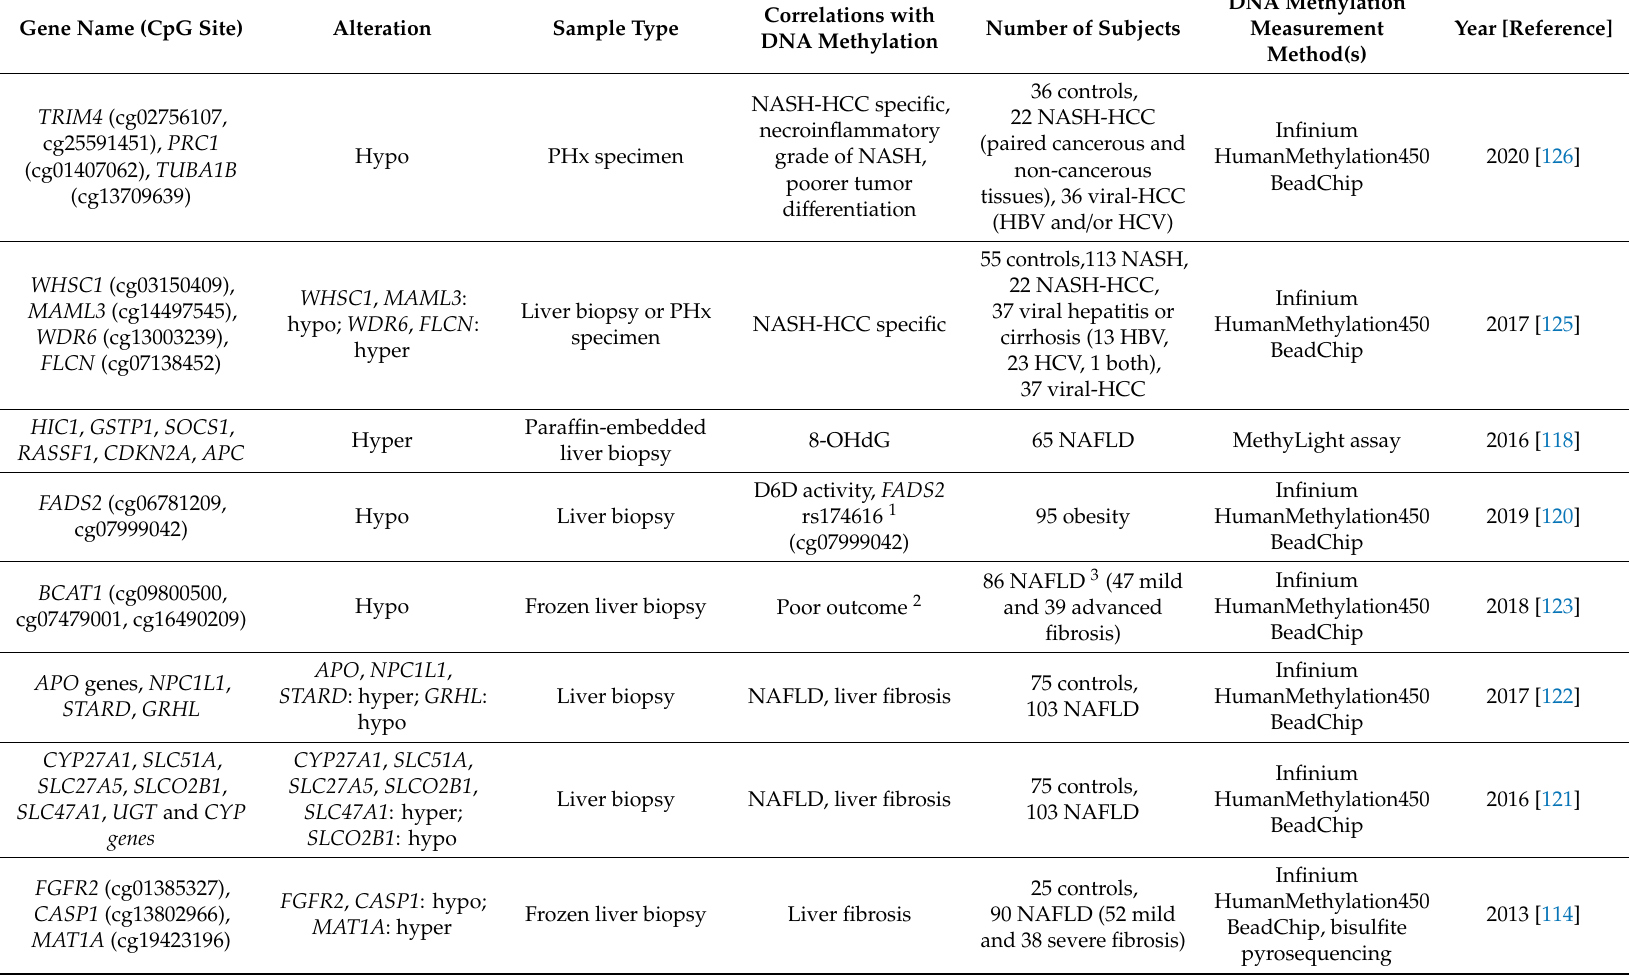
Table 1. Alteration of hepatic DNA methylation in NAFLD